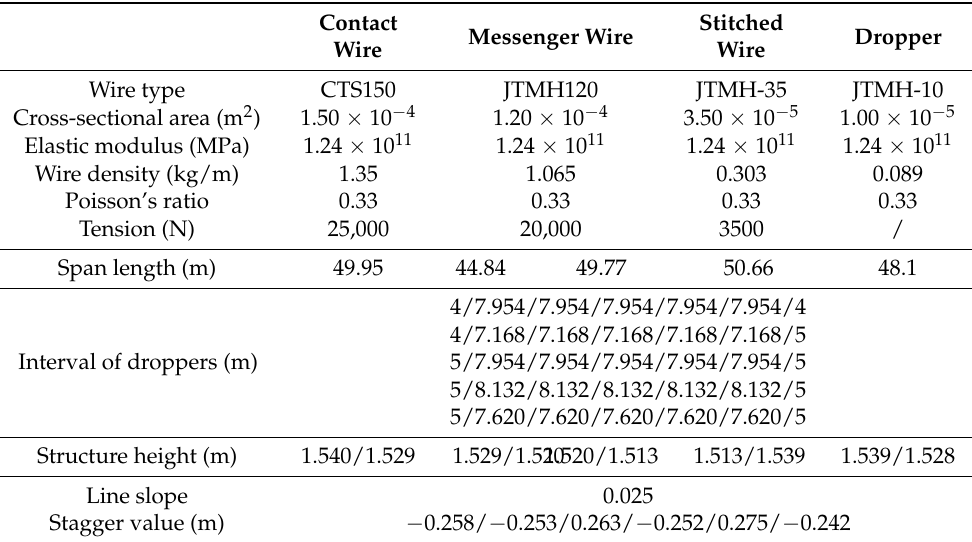
Table 2. Parameters of the span where the central anchor was located.